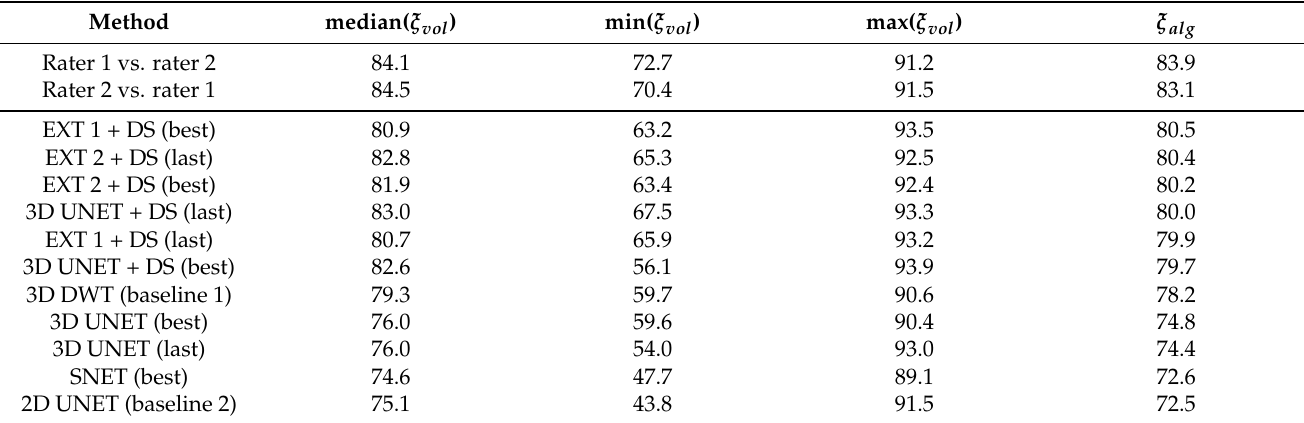
Table 2. Effectiveness of the proposed follicle detection methods compared to the state-of-the-art and inter-rater variability. Presented are the final score statistics and the overall algorithm’s score on the USOVA3D database. Entries are sorted with respect to the overall score.